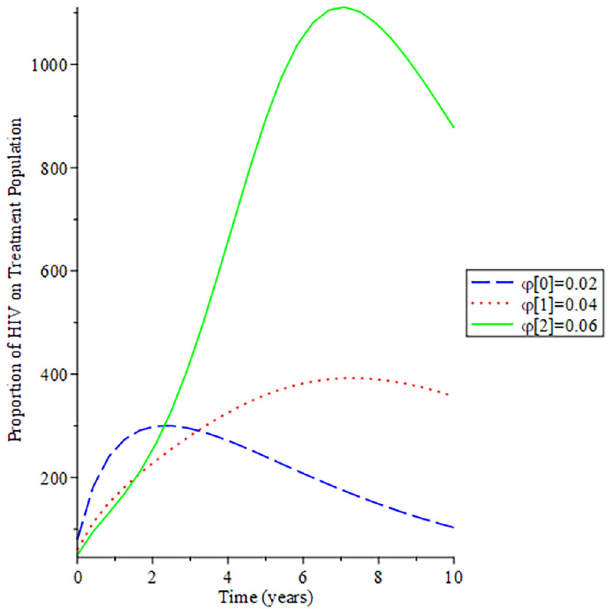
Figure 10. Behavioral dynamics of Infected HIV on treatment population when varying vertical transmission φ with